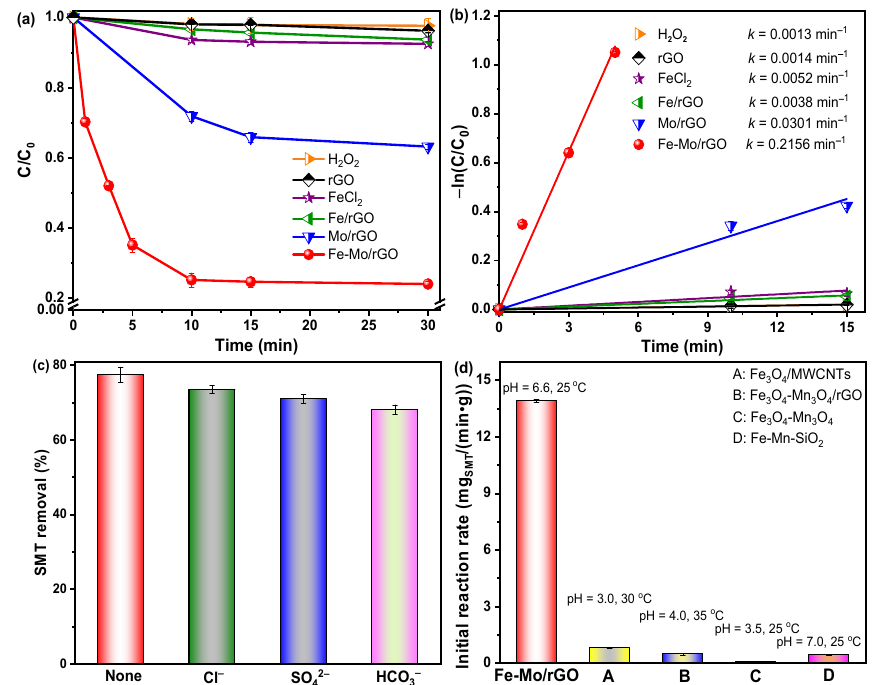
Figure 4. ( a ) The SMT removal and ( b ) the kinetics curves for the SMT removal in the Fenton-like reaction over different catalysts. ( c ) Effect of 0.076mM of different inorganic anions for SMT removal over Fe-Mo/rGO catalyst. ( d ) Comparison of the initial reaction rate for the SMT removal over different catalysts. ([SMT] 0 = 0.076 mM, [H 2 O 2 ] 0 = 20 mM, pH = 6.57, T = 25 °C, [Catalyst] = 0.2 g/L).